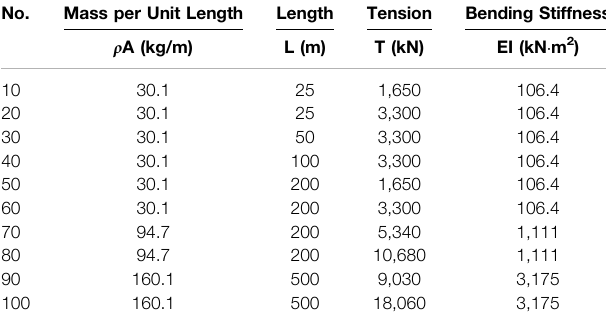
TABLE 1 | Cable parameters in numerical veri fi